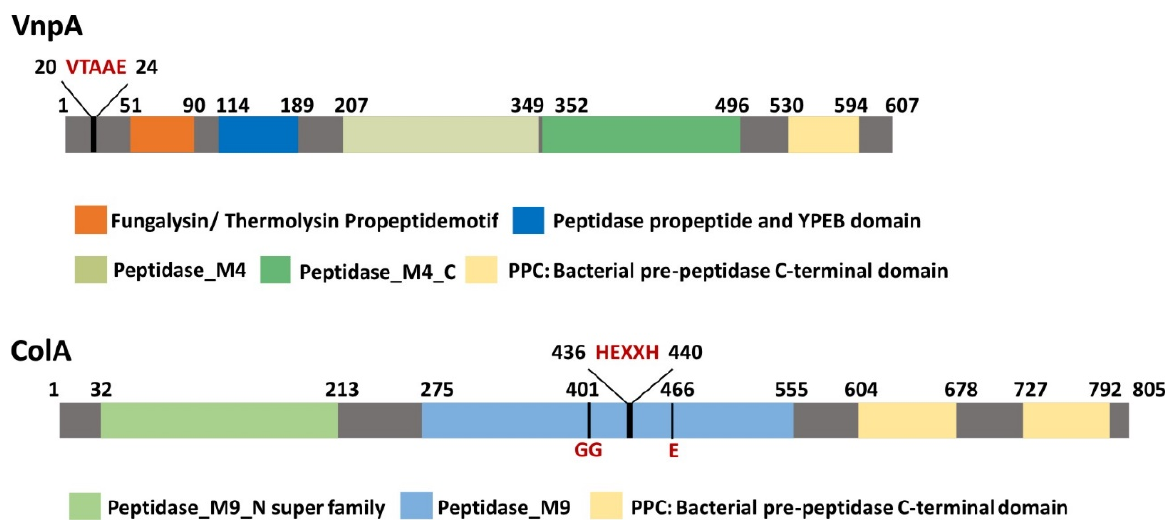
Figure 1. Conserved domains and motifs found in VnpA and ColA metalloproteases.